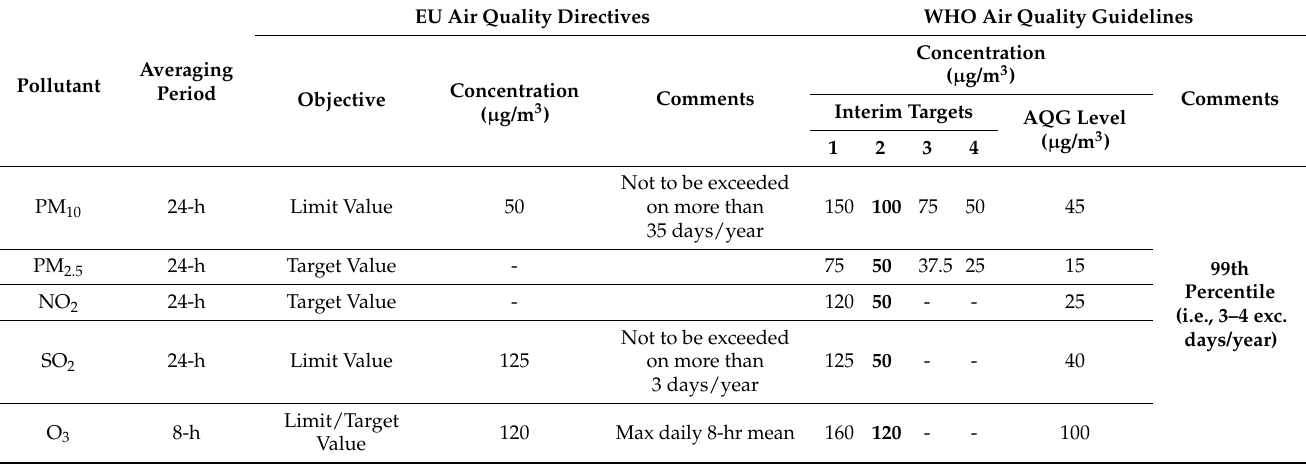
Table A1. EU Air Quality Directives [55] and WHO Air Quality Guidelines